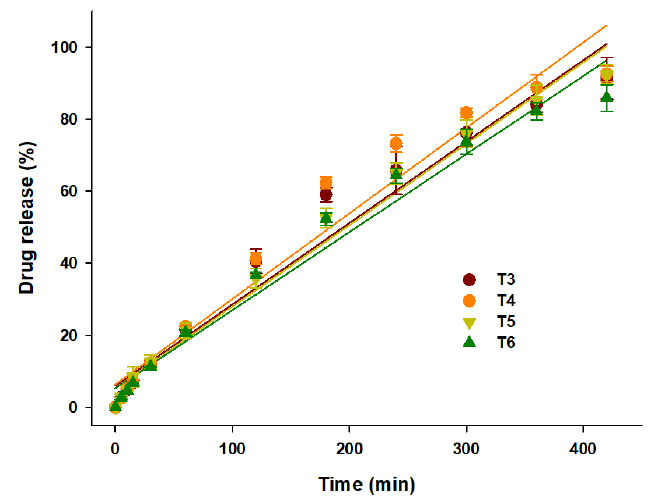
Figure 8. Linear fitting of drug release from T3, T4, T5, and T6 over 10 h.